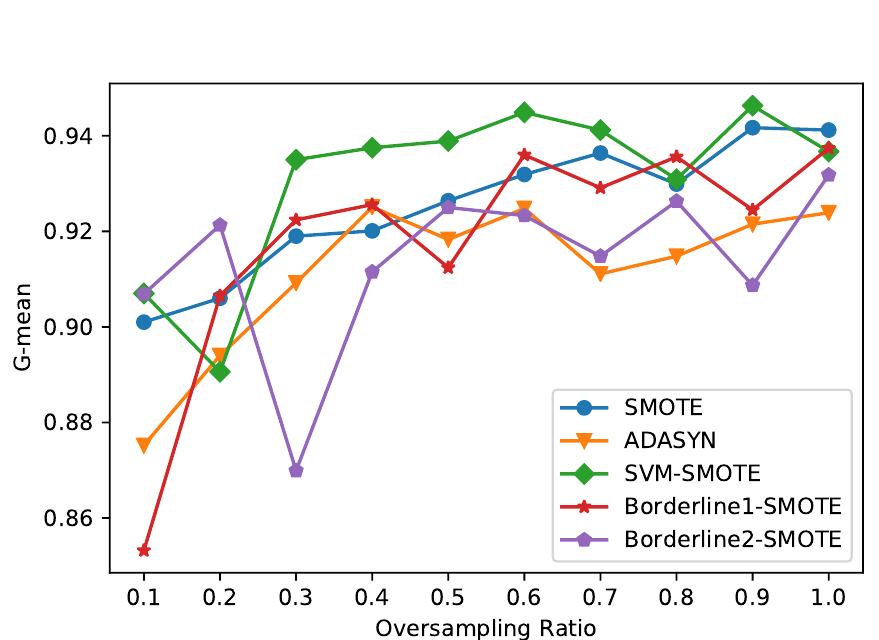
Figure 8. GM evaluation of different values of oversampling ratios and different oversampling techniques (SMOTE, ADASYN, SVM-SMOTE, Borderline1-SMOTE, and Borderline2-SMOTE).